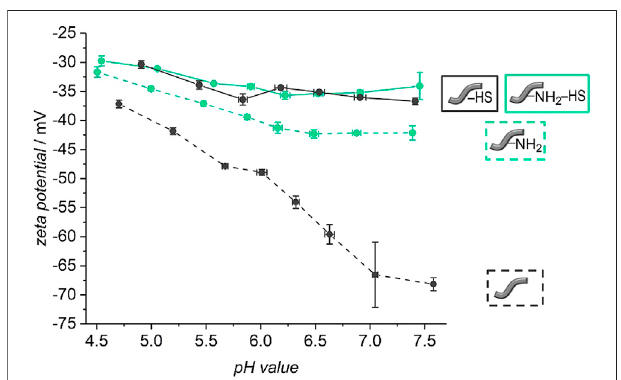
FIGURE 8 | pH-dependent zeta potential titration curves of unmodi fi ed (dashed grey line) and amino-modi fi ed (dashed green line) fi bers as well as for unmodi fi ed (continuous grey line) and amino-modi fi ed (continuous green line) fi bers covered with heparan sulfate after a release of 21 days in PBS (with 0.1% BSA, 37 °